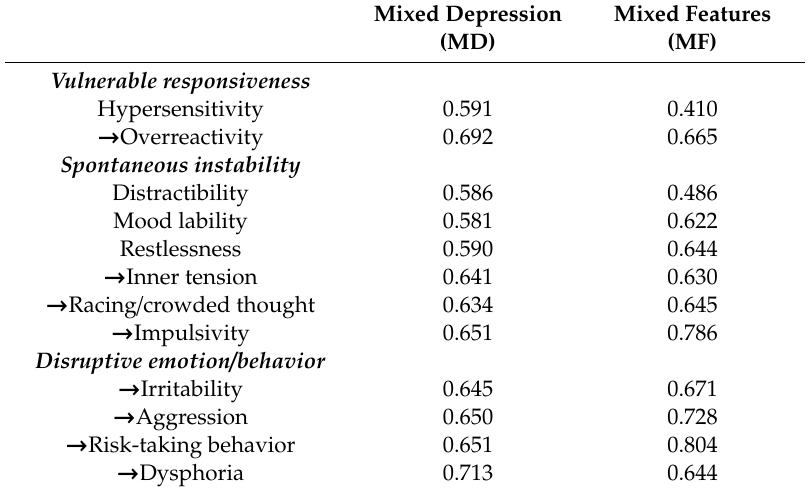
Table 2. Values of AUC for ROC curves di ff erentiating mixed depression or mixed features.